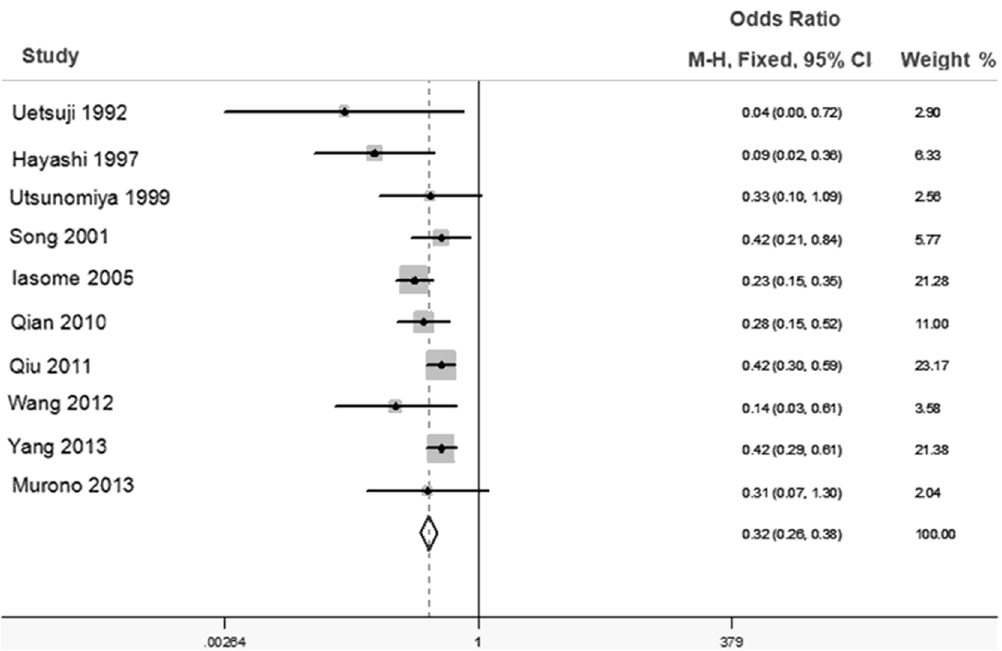
Figure 3. Funnel plot analysis of potential publication bias.